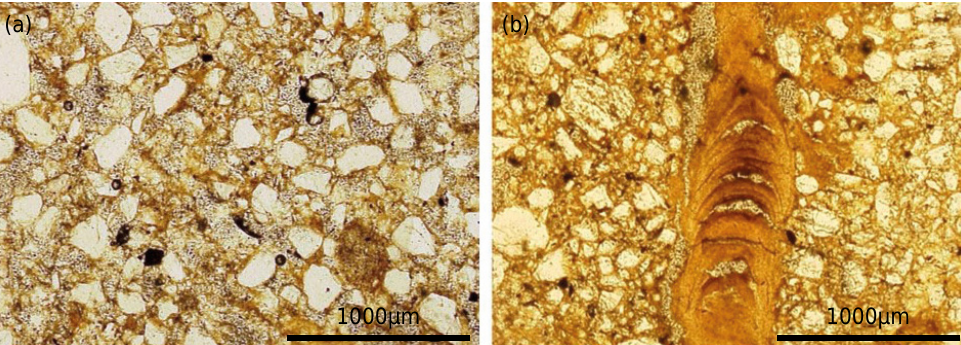
Figure 7. (a) Microphotograph of Eb horizons: chitonic-gefuric relative distribution with monic zones; pellicular grain microstructure. (b) Microphotograph Btb horizons: porphyric relative distribution; and massive and dense microstructure. Pores infilled by illuvial